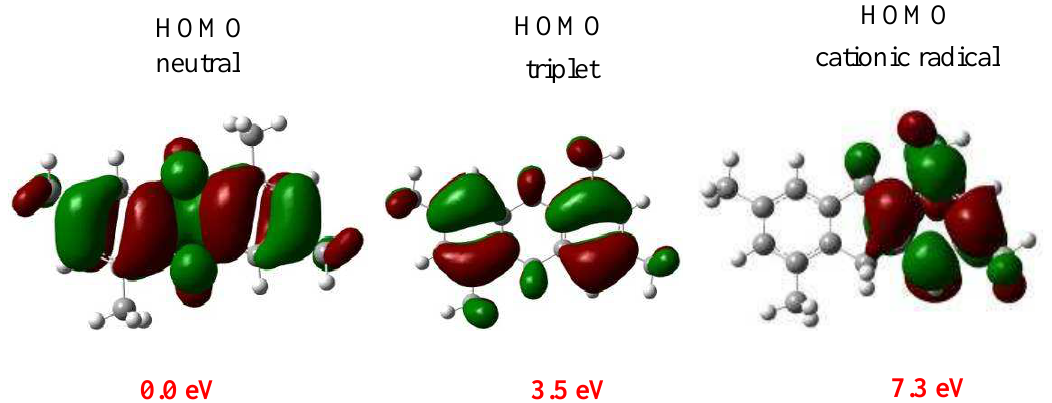
Figure 4. Shape of molecular